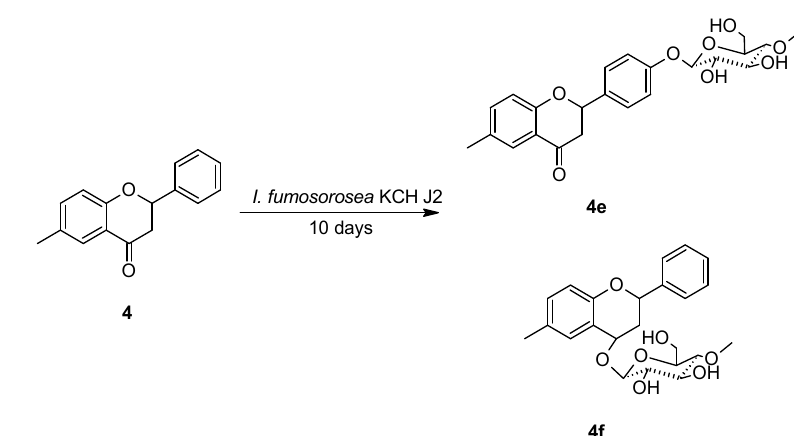
Scheme 11. Key COSY (on the left) and HMBC (on the right) correlations for the structure elucidation of product 4e .